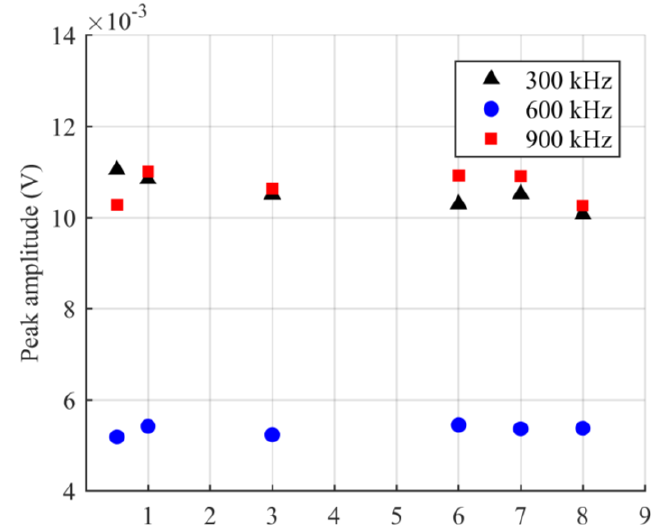
Figure 8. Maximum amplitude of the ultrasonic waveforms detected in the experiment to evaluate durability of the optical fiber-based waveguide at the temperature of 1100 °C.